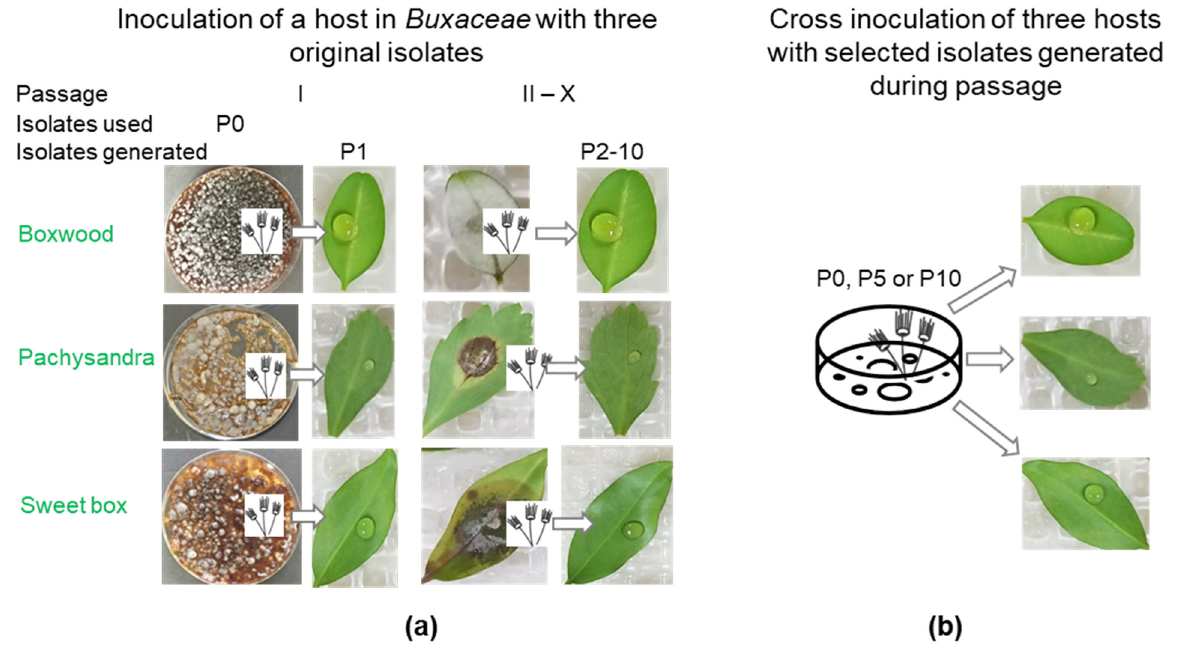
Figure 1. Schematic of the experimental setup. ( a ) Serial passage experiments on isolates’ originating host plants: boxwood, pachysandra, and sweet box, which generated isolates P1–P10. For passage I, inoculum was prepared from conidia formed on culture media (P0). For passages II–X, inocula were conidia from infected leaves of the previous passage (I–IX). ( b ) Post-passage experiments evaluating infectivity, lesion size, and ability to sporulate with selected original isolates (P0) and isolates generated during passages (P5 and P10) on all three host plants.